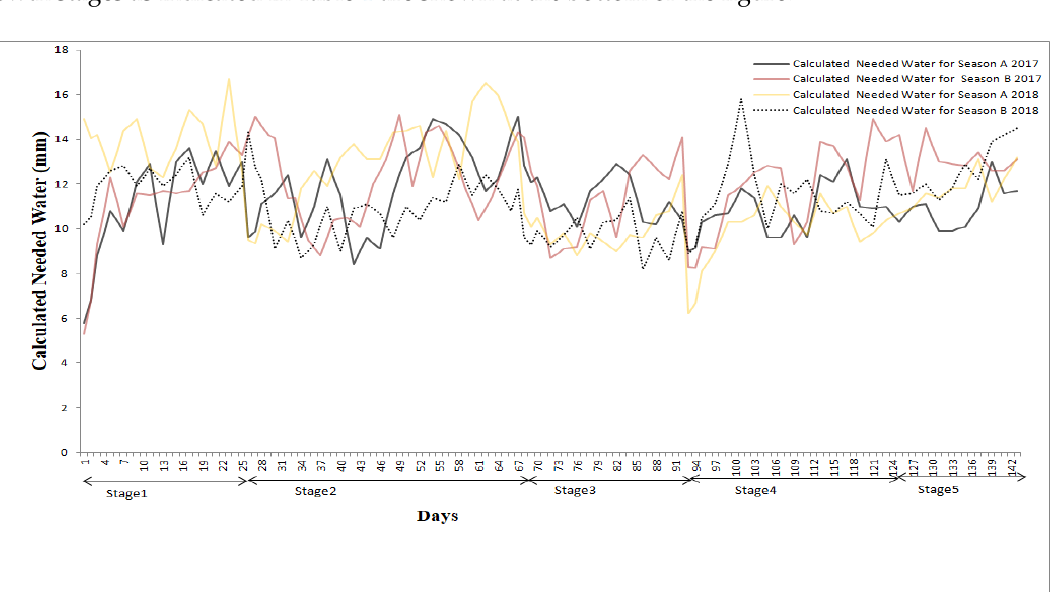
Figure 5. Results for Matlab simulation of four seasons using the Markov chain process